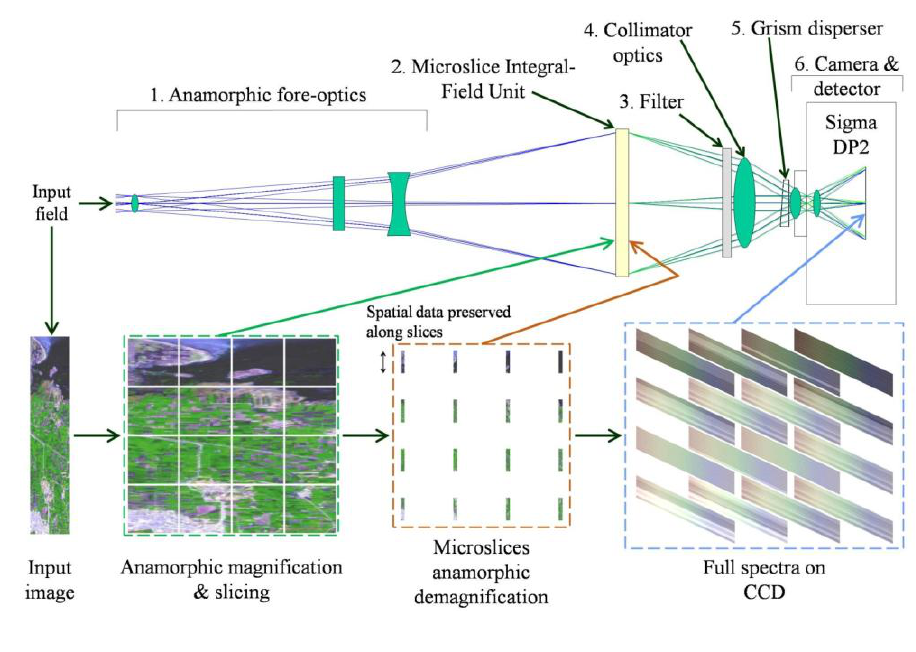
Figure 1. Basic principle of the microslice